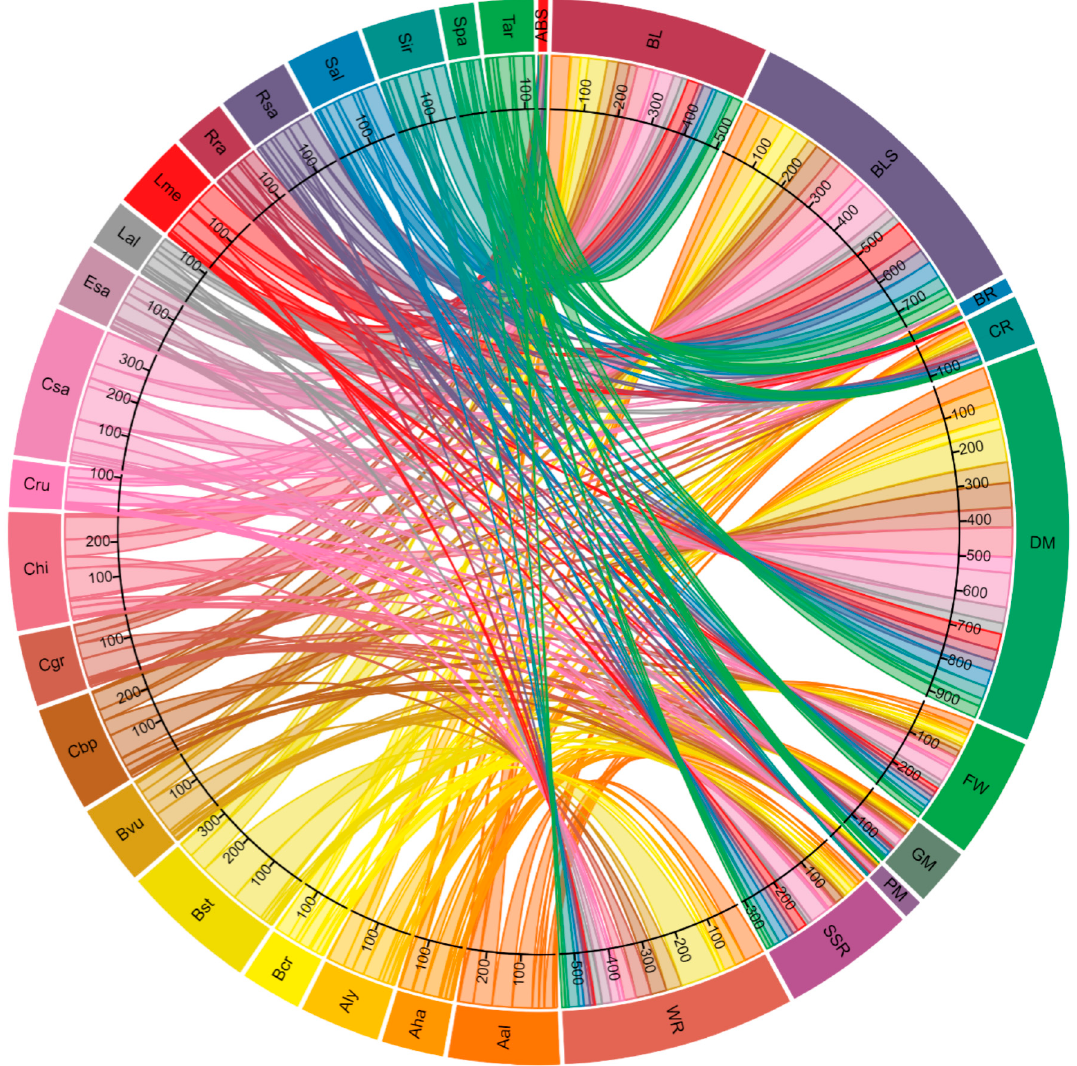
Figure 3. The number and distribution of cloned disease resistance gene homologs associated to Alternaria black spot (ABS), blackleg (BL), black rot (BR), bacterial leaf spot (BLS), clubroot (CR), downey mildew (DM), Fusarium wilt (FW), grey mould (GM), powdery mildew (PM), Sclerotinia stem rot (SSR) and white rust (WR) resistance in Arabidopsis halleri (Aha), Arabidopsis lyrata (Aly), Arabis alpina (Aal), Barbarea vulgaris (Bvu), Boechera stricta (Bst), Brassica cretica (Bcr), Camelina sativa (Csa), Capsella grandiflora (Cgr), Capsella bursa-pastoris (Cbp), Capsella rubella (Cru), Cardamine hirsuta (Chi), Eutrema salsugineum (Esa), Leavenworthia alabamica (Lal), Lepidium meyenii (Lme), Raphanus raphanistrum (Rra), Raphanus sativus (Rsa), Sinapis alba (Sal), Sisymbrium irio (Sir), Schrenkiella parvula (Spa) and Thlaspi arvense (Tar) genomes.